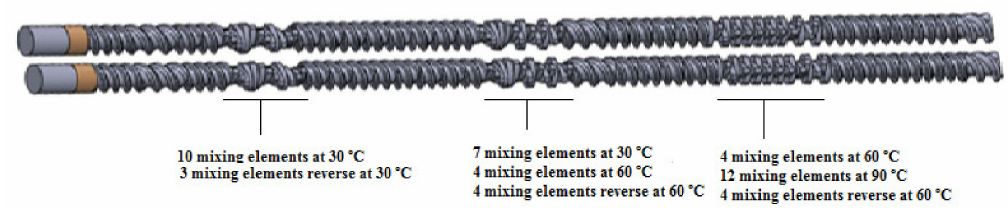
Figure 5. Different sections of a twin-screw profile for the preparation of CNFs [87].